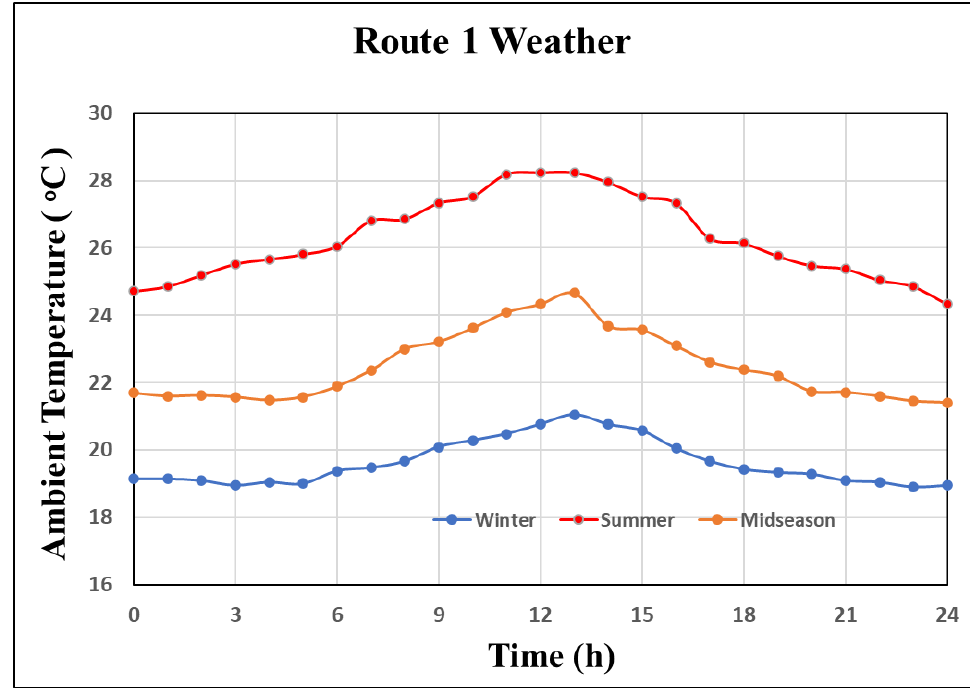
Figure 4. Ambient temperature of all seasons for the first journey route Shanghai, China, to Los Angeles, USA.